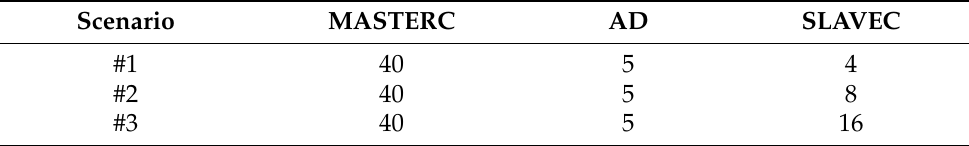
Table 3. Possible scenarios for case study 1.